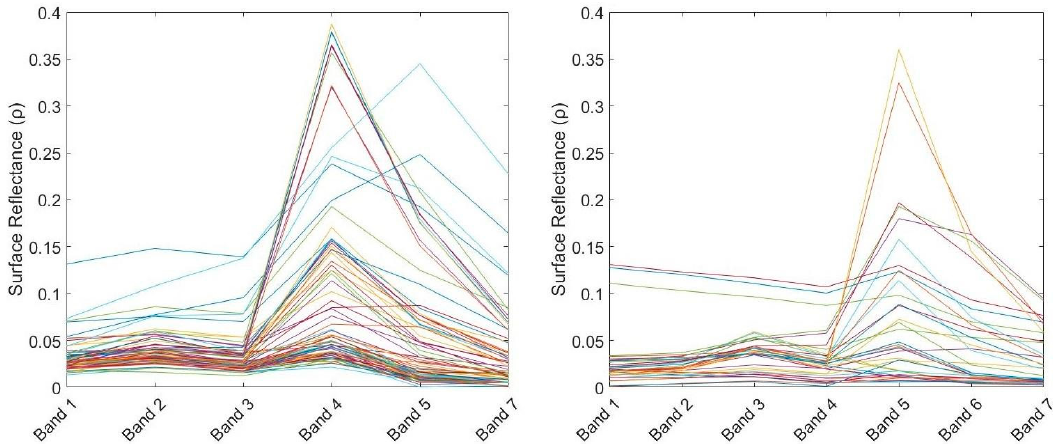
Figure 3. Per-band reflectance distributions for all Landsat 5 (left) and 8 (right) satellite-based reflectance observations. As each band captures a very specific wavelength, the graphs approximate the spectral signatures of each sampling site pixel.